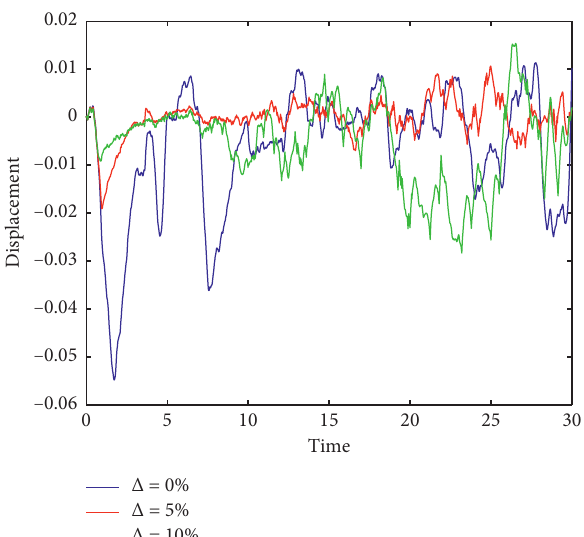
Figure 16: The variations of horizontal displacement of 11 th story for the active system and different values of Δ